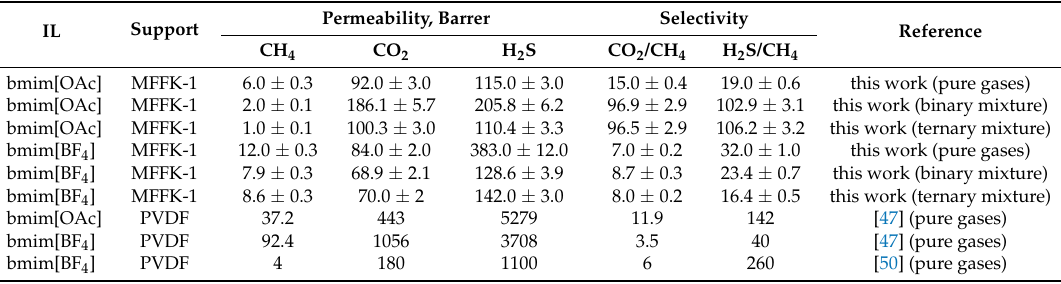
Table 4. Comparison of the gas permeability and selectivity of the supported ionic liquid membranes